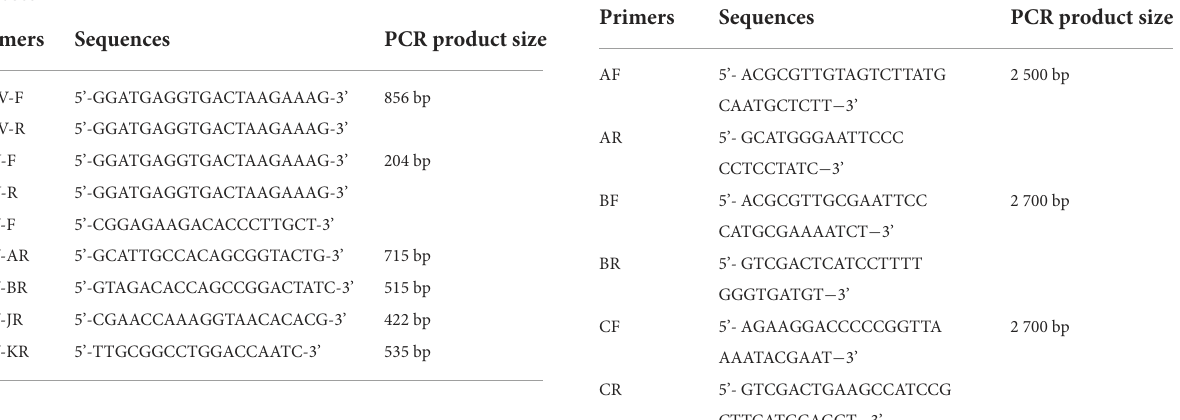
TABLE 2 Sequences of the segmented